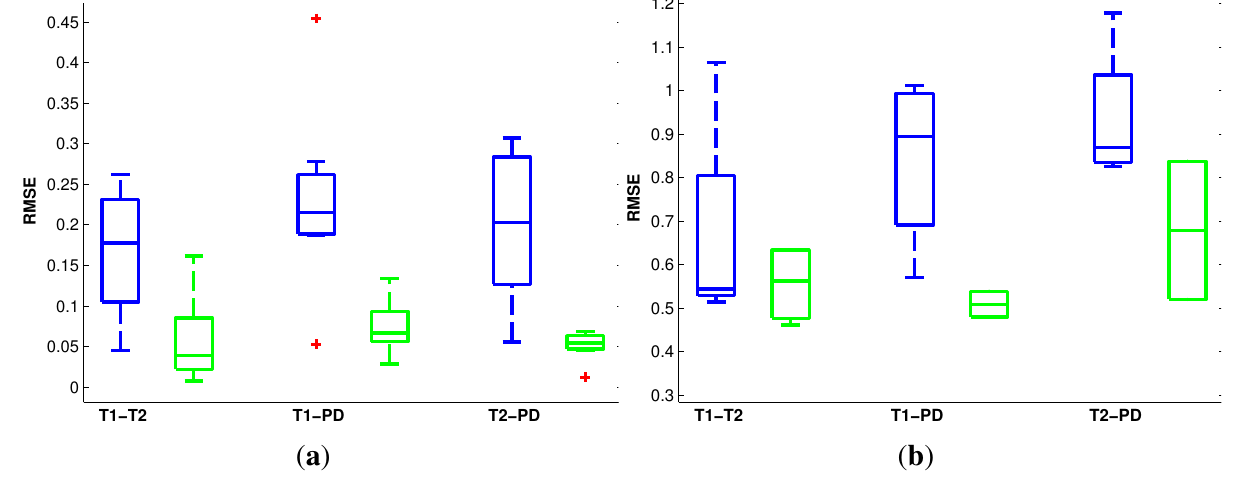
Figure 5. Boxplots of the root mean squared registration errors (in mm) for the BrainWeb data sets. For each pair of modalities, the left-most (blue) boxplots correspond to using MI, while the right-most (green) ones correspond to diffusion distance. Red crosses indicate outliers. ( a ) Rigid registration; ( b ) non-rigid